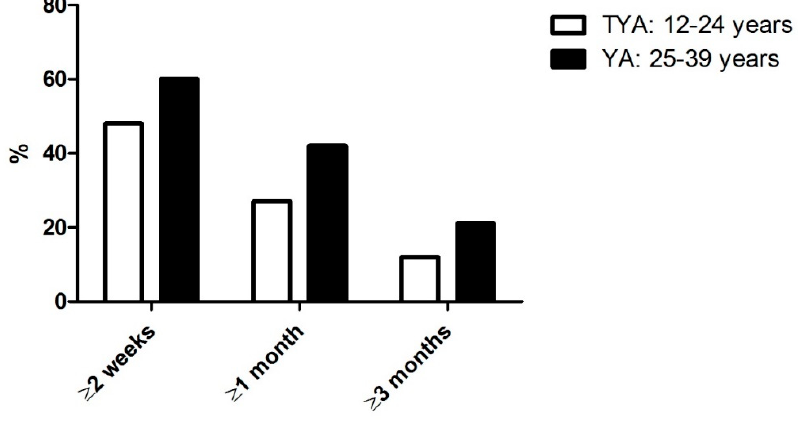
Figure 3. Proportion of participants by patient and interval